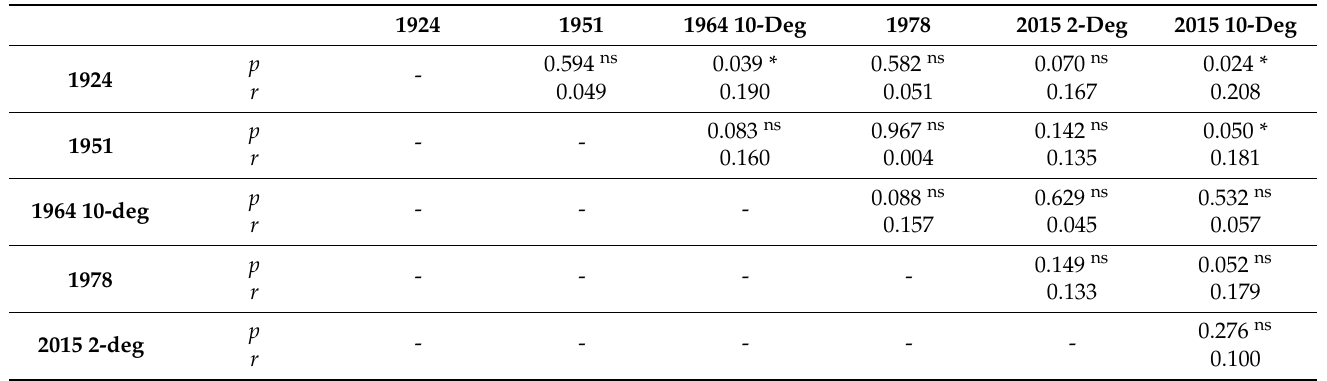
Table 7. Rank sum test and effect size for CCT ( p -value and effect size ( r )).